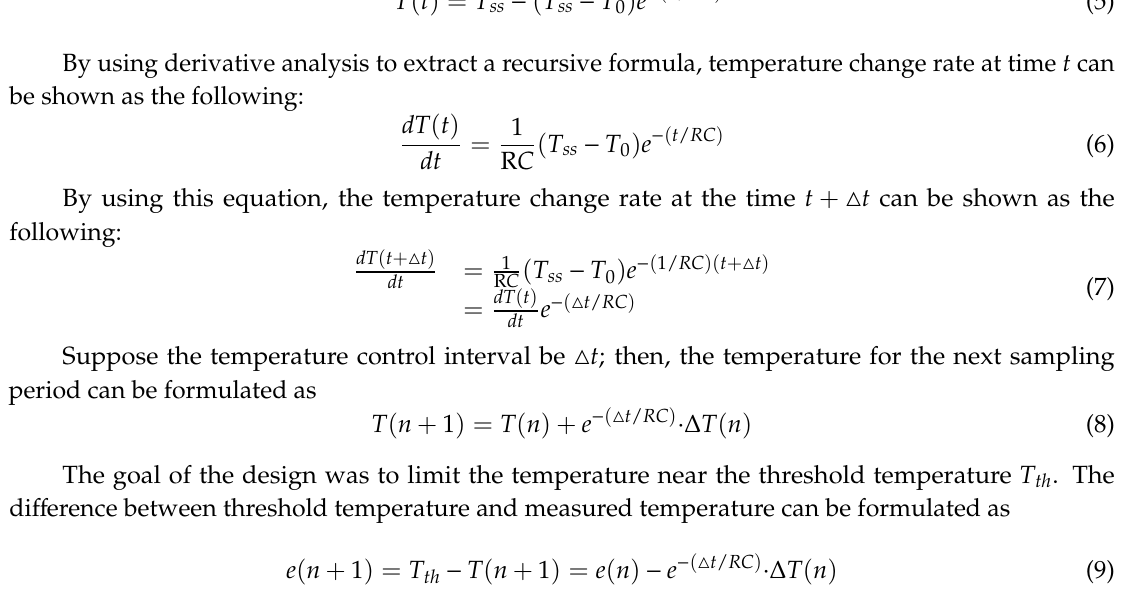
Low (4) Defuzzification of Fuzzy Rule Outputs: Based on the fuzzy logic rules and fuzzified input parameters, we adopted the mean-of-maxima method for the defuzzification and conversion of the output into a frequency ratio of the processor. The membership function of the output F is shown in Figure 5. 4. Experimental Evaluation In our experiment, a 3D-stacked NUCA cache architecture consisting of four cores with three L2 cache layers was used. Every core had a 32KB L1 instruction cache and a 32KB L1 data cache. Four cache banks were formed into a cache zone, and these were stacked right above each core. The